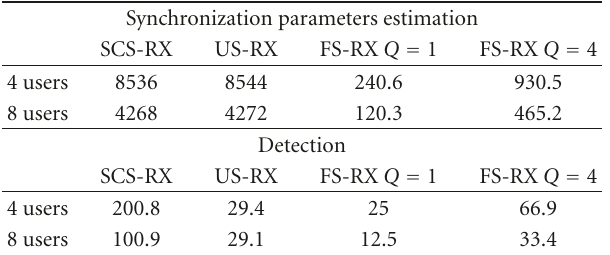
Table 1: Complexity Comparison (complex operations per second per